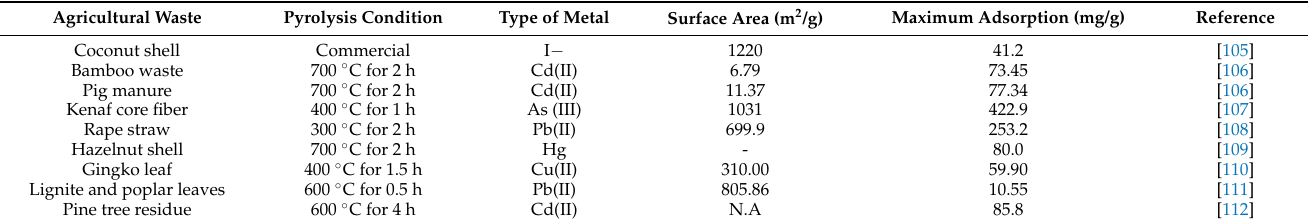
Table 2. Illustration of studies presenting the adsorption capacity of different agricultural-waste- based nano-activated